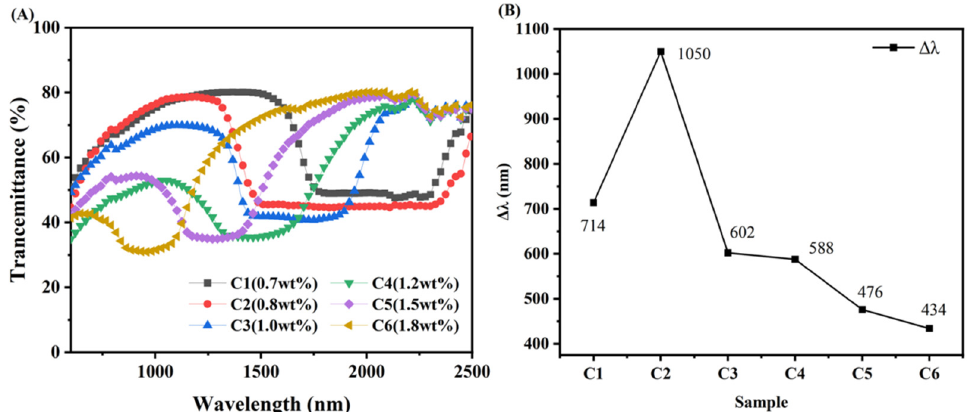
Figure 8. Transmission spectra ( A ) and Δλ of samples C1-C6 ( B ).